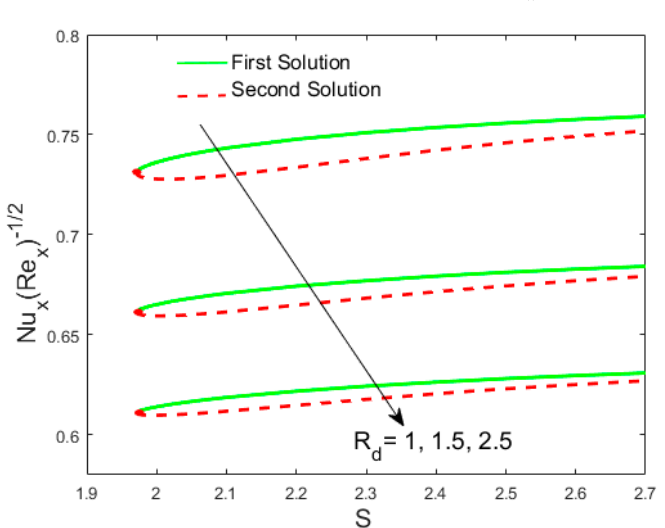
Figure 19. Influence of R d versus S on Nu x Re .